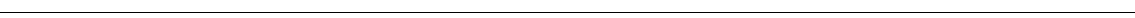
Fig. 5 Combined loss of Vhl and Pbrm1 is suf fi cient to initiate renal carcinogenesis. a Top: schematic of crossings, tamoxifen (TAM) administration and resulting cohorts. Bottom: Kaplan – Meier renal cancer-free survival of control and mutant mice. b Representative Haematoxylin and Eosin (H&E) and